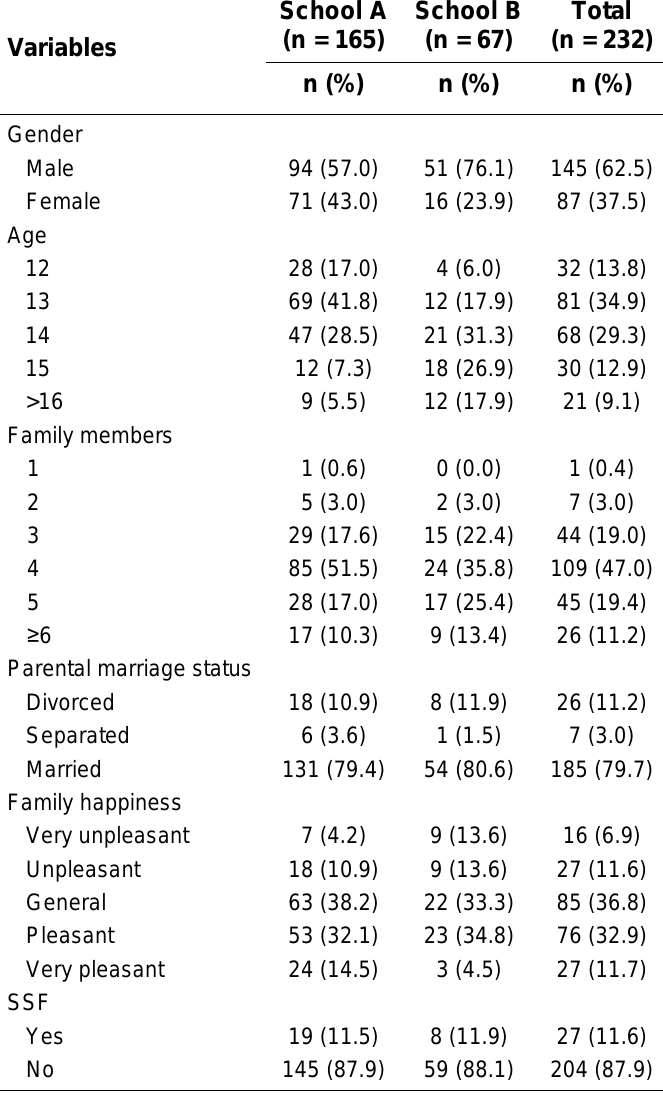
Participant Characteristics of P.A.T.H.S. Secondary